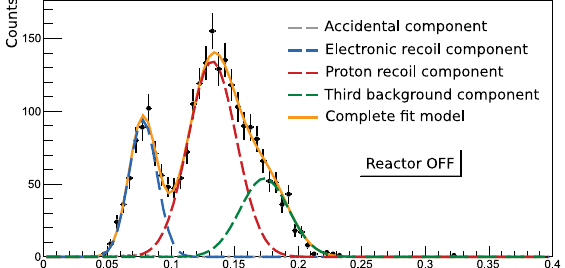
Figure 5. Distribution of the PSD value for events in cell 2 for reconstructed energy bin around 3.375 MeV, collected in 84 days of reactor turned off. The different components of the fit are also indicated, with the electronic component at low Q tail / Q tot and the third Gaussian component at high Q tail / Q tot